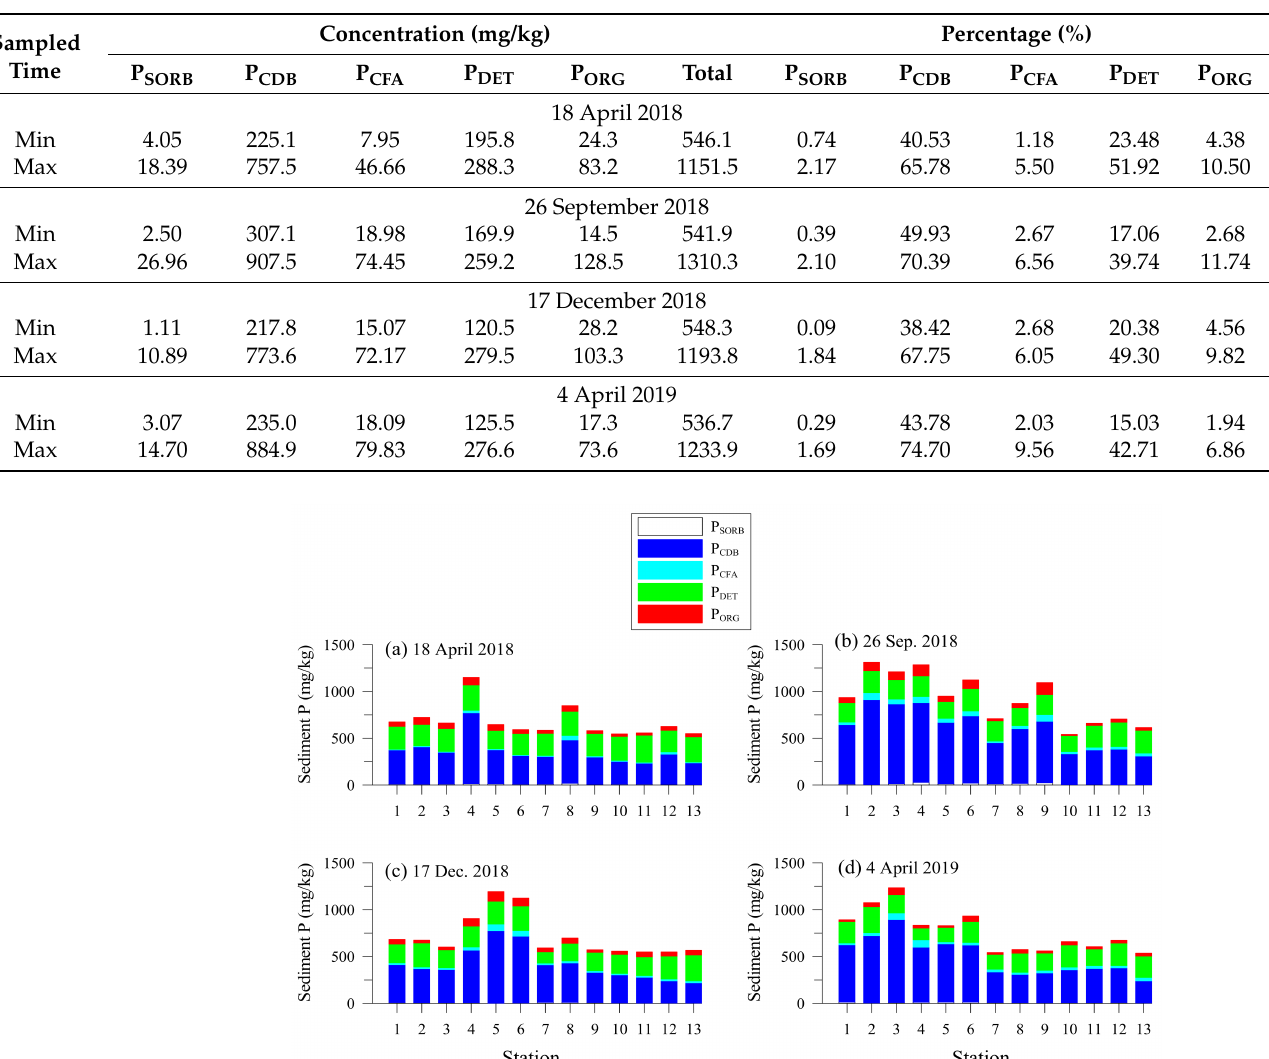
Table 2. The concentration and percentage ranges of sedimentary P in the five fractions of the sediments collected. from the DRE.